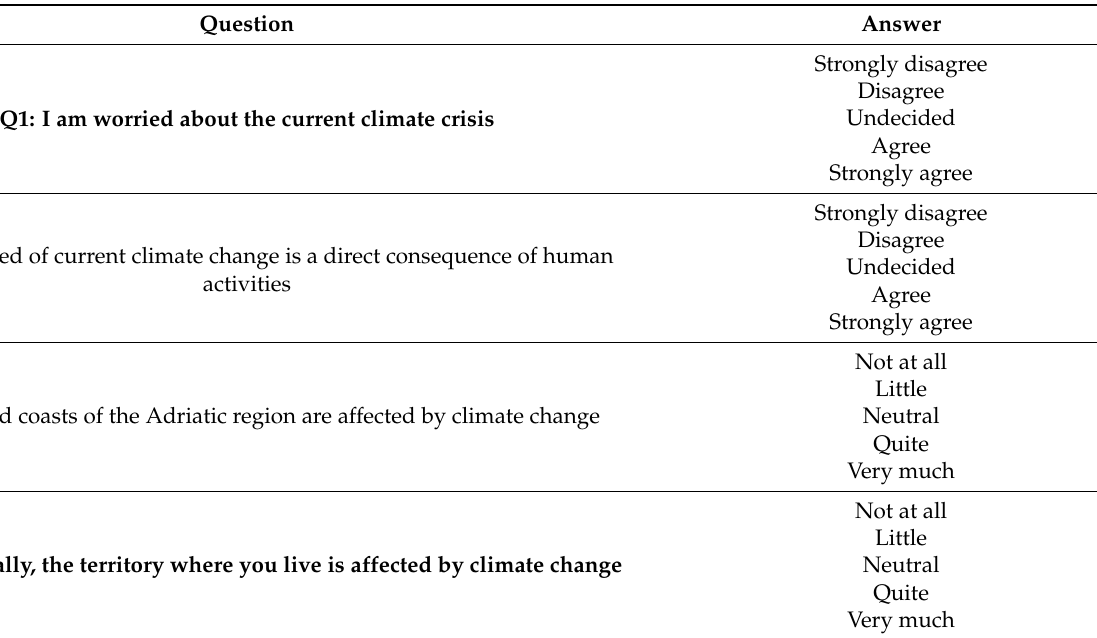
Table A1. Perception questionnaire administered to the population for the RESPONSe Project activities. The questions providing information about the perception of geohazards are in